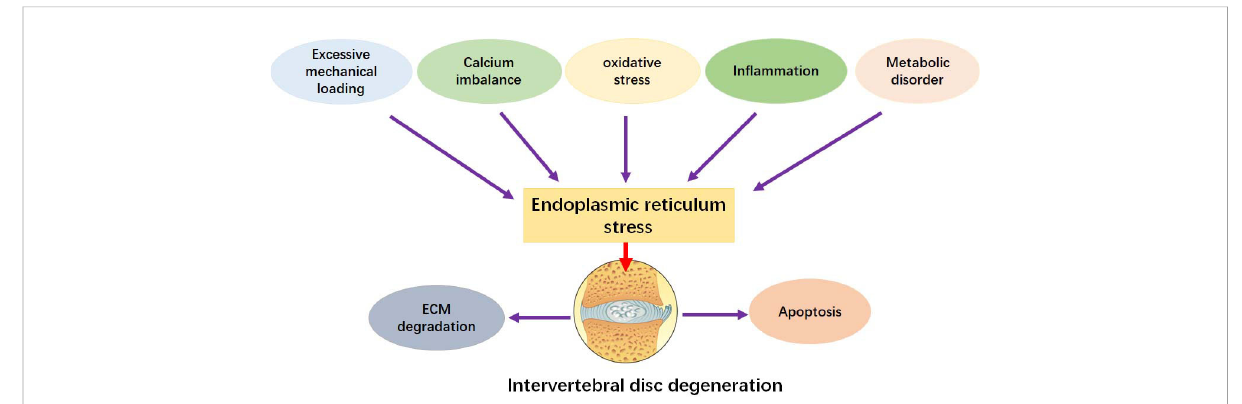
FIGURE 2 ERS promotes the development of IDD. ERS can be activated by in fl ammation, apoptosis, senescence, oxidative stress, mechanical pressure, calcium dyshomeostasis, and metabolic disorder. These factors can facilitate the pathological changes by stimulating